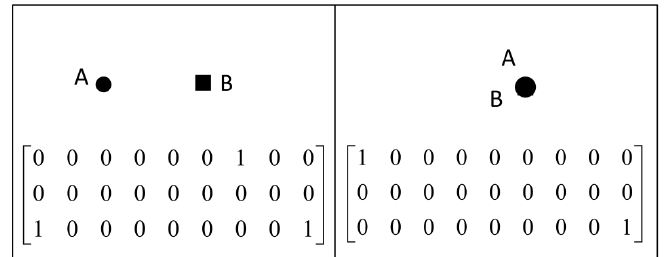
Figure 3. The formalism of the 27-intersection model (27IM) and the corresponding geometric interpretations between two points.